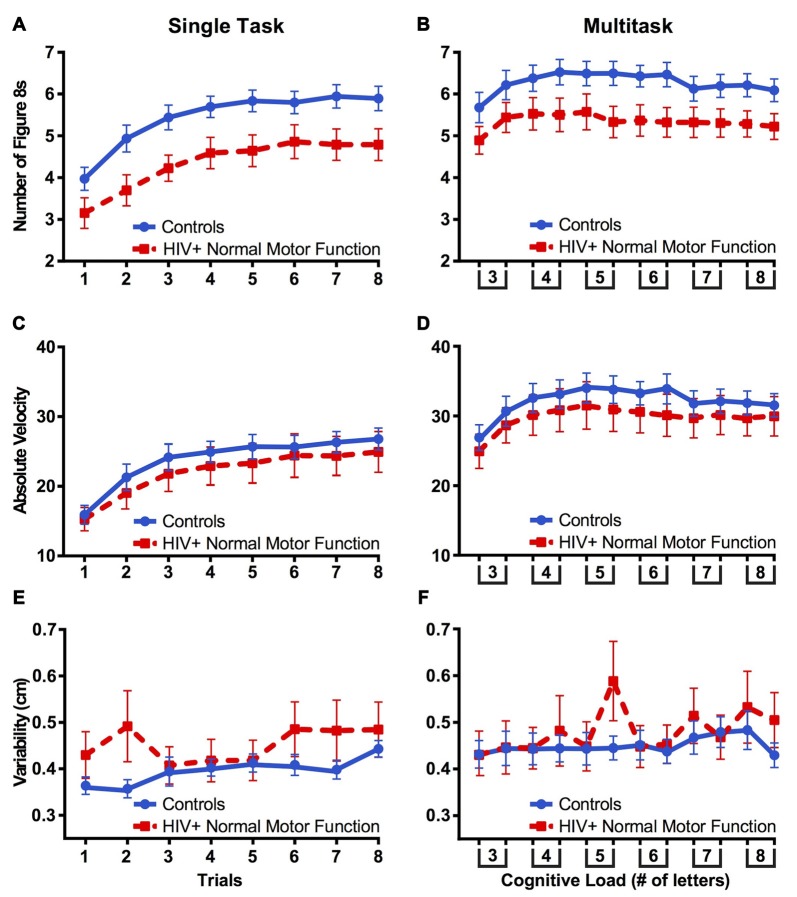
Fourteen HIV+ participants classified with normal motor function via the Unified Parkinson’s Disease Rating Scale (UPDRS) and supplementary motor function exams (red dashed line) drew fewer figure 8s compared to healthy controls (A,B). Groups did not differ in terms of absolute velocity (C,D) or variability (E,F). These results indicate that a “normal” neurological exam of motor function may not capture subtle motor impairments when performing fine motor tasks or a motor task combined with a cognitive load. Error bars represent standard error of the mean.